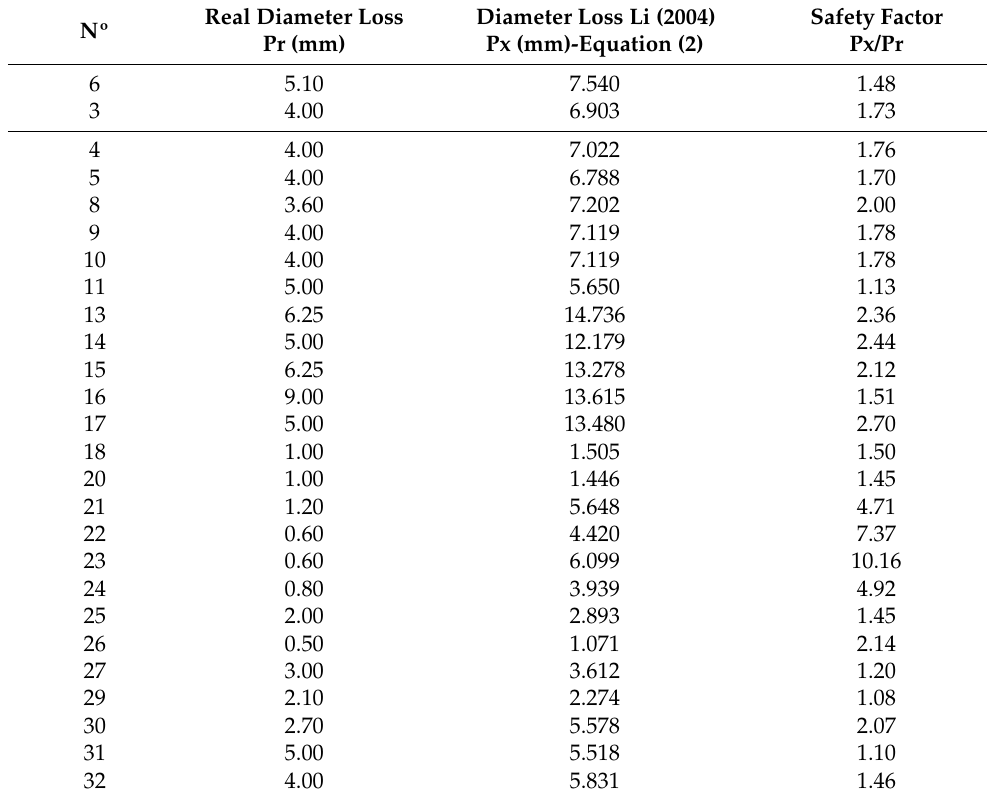
Table 7. Case studies with favourable results using the Li (2004 a) model.